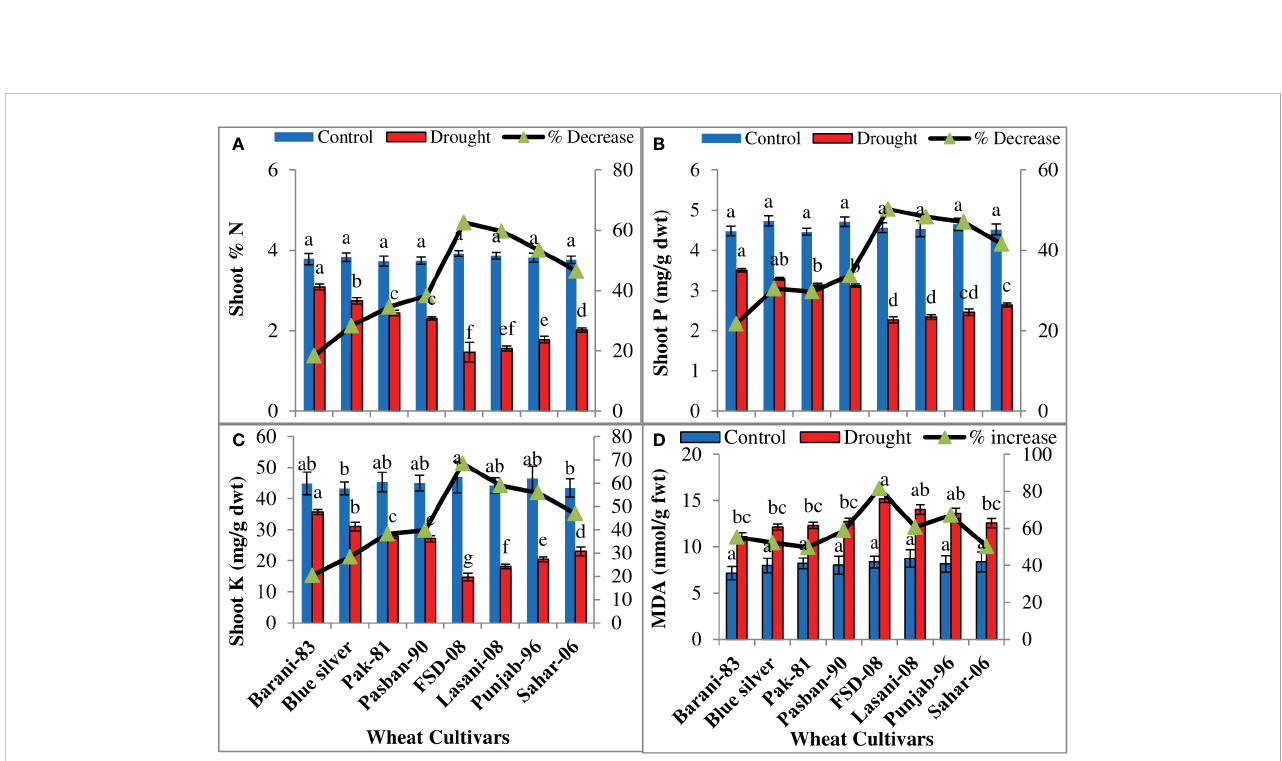
FIGURE 5 Accumulation of mineral nutrients and MDA in selected wheat cultivars subjected to control or drought stress at adult stage. Means (± SE; n=5) are presented on the primary vertical axis, while percent decrease value is presented on the secondary vertical axis. Different letters represent signi fi cant differences among cultivars at p < 0.05 according to LSD test. (A) Shoot N, (B) shoot P, (C) shoot K + , and (D) MDA.